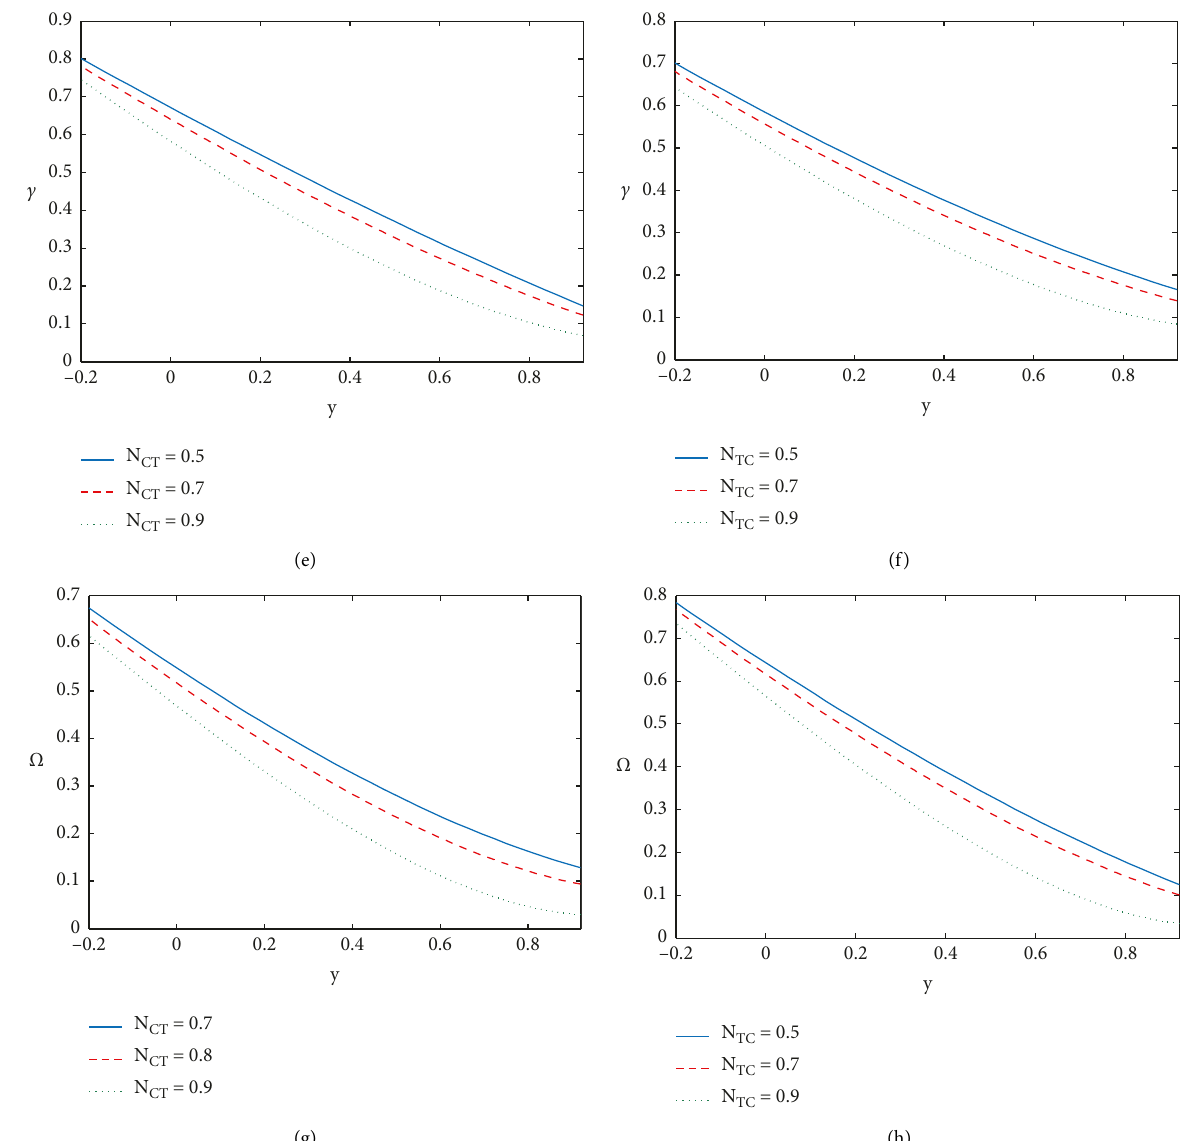
Figure 4: Effects of Soret ( N